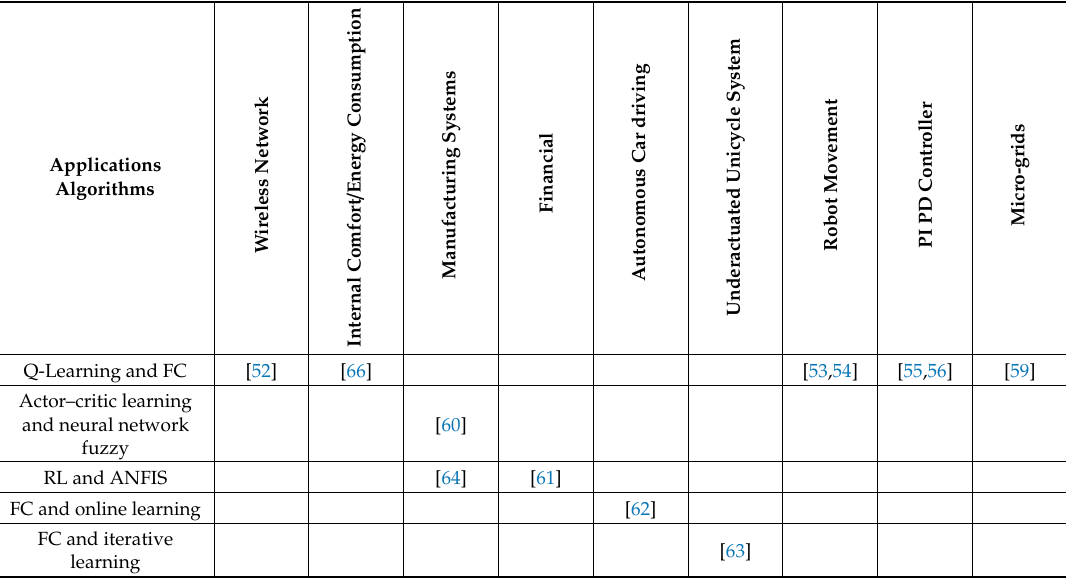
Table 1. Joint applications of fuzzy control (FC) and reinforced learning